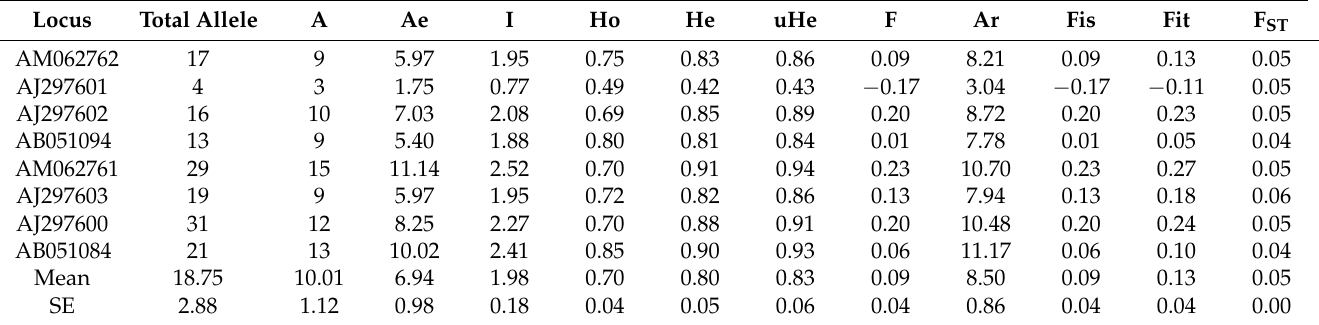
Table 4. Mean diversity indices and F-statistic (F IS , F IT , F ST ) values across eight microsatellite markers. Locus